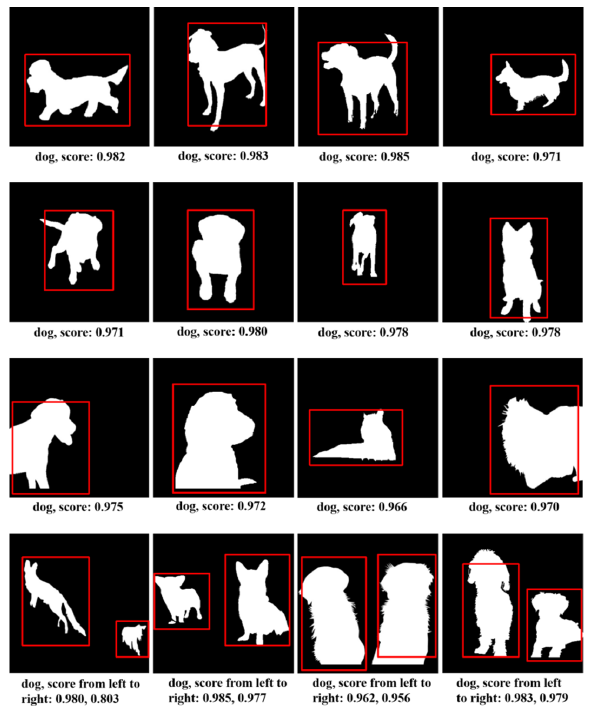
Figure 5. The 16 representative dog contour shape maps were selected from the test set with their confidence and predicted bounding boxes.